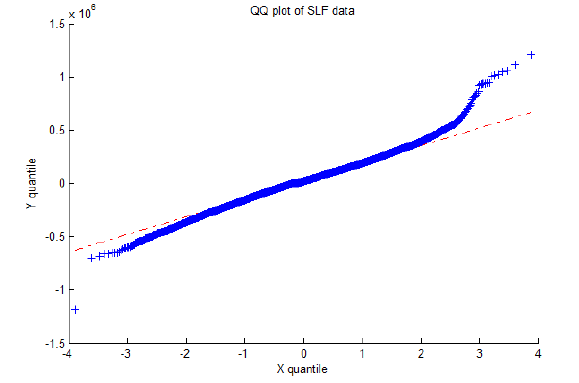
Figure 2 the non-Gaussian verification of SLF